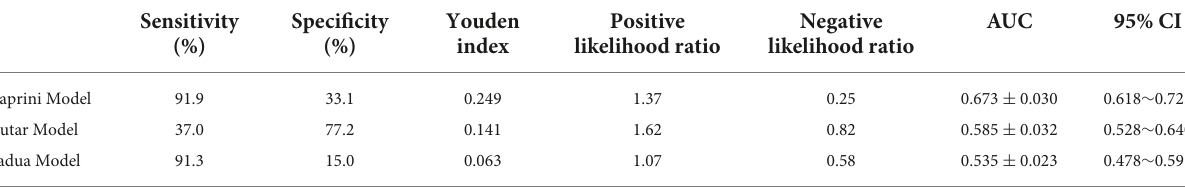
TABLE 3 Sensitivity, specificity, Youden index, and AUC of the three risk assessment models for thrombosis.